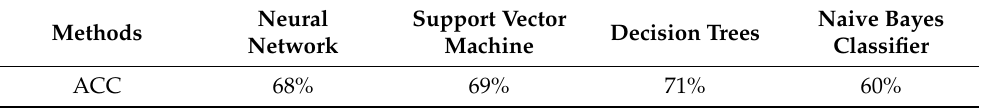
Table 3. Results of the preliminary comparative analysis of various methods of artificial